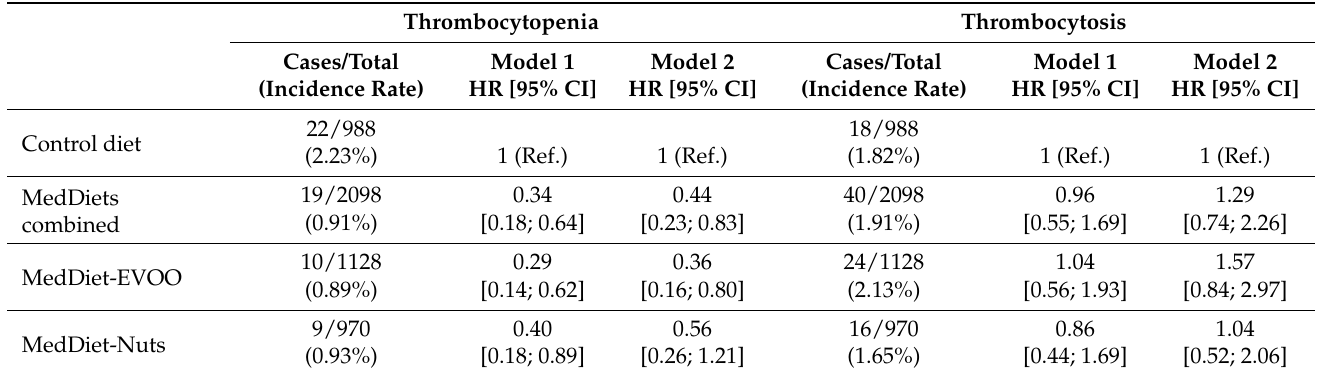
Table 3. Incidence of platelet count-related alterations in the study population 1